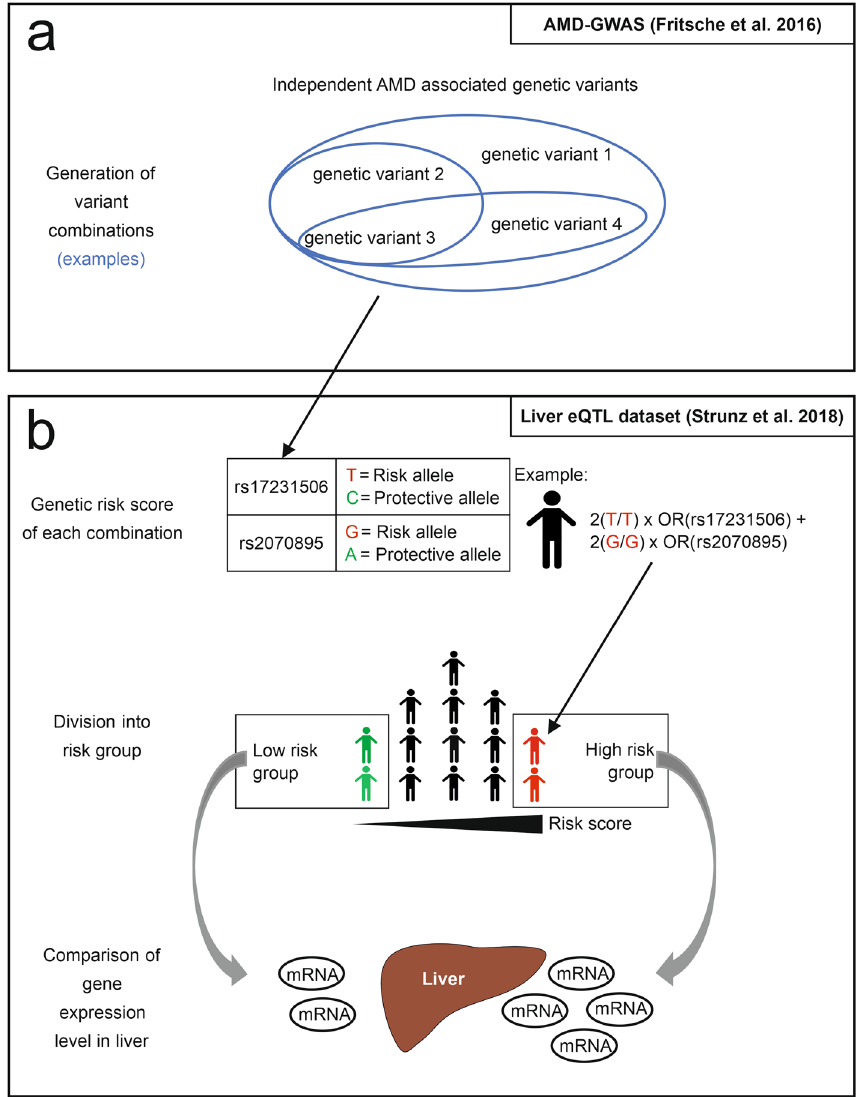
Figure 2. Schematic project workflow. ( a ) AMD-associated genetic variants were used to generate unique variant combinations. ( b ) Based on each combination, a genetic risk score (GRS) was calculated for 588 individuals represented in the liver eQTL dataset 7 . According to the individual genetic risk profile, each person was graded into risk groups, with a low-risk group containing the 30%-quantile of the lowest scores and a high- risk group containing the 30%-quantile of the highest scores. Consequently, expression of 24,123 genes in liver tissue were compared between the risk groups.